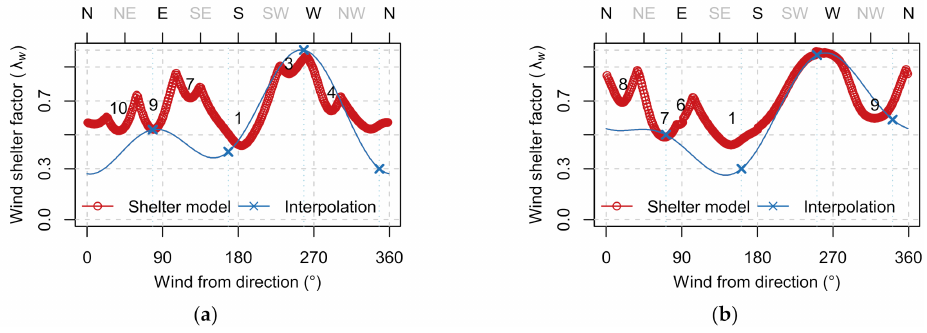
Figure 24. Air infiltration sheltering ( a ) for the GBORO case-building; ( b ) and for the UKULE case building. The combined directional shelter factor for the three exterior facades of either plotted over the wind direction. Only the obstacles that yielded an impact to the shelter factor are